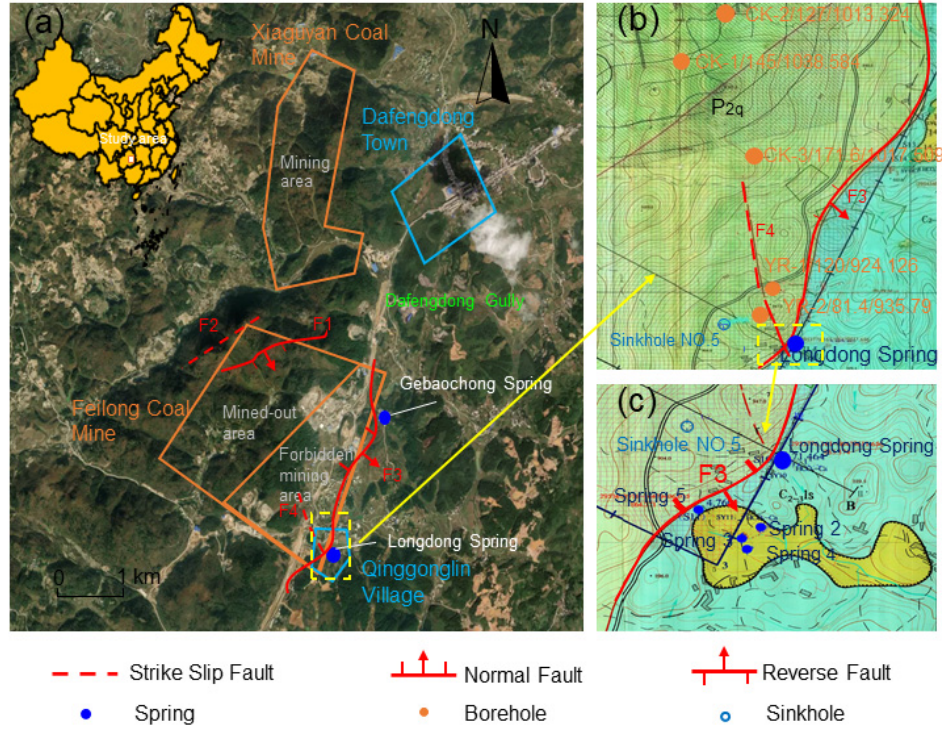
Figure 1. Location of the study area: ( a ) distribution of the main relevant areas; ( b ) location of the main boreholes; ( c ) Longdong Spring and surrounding springs.